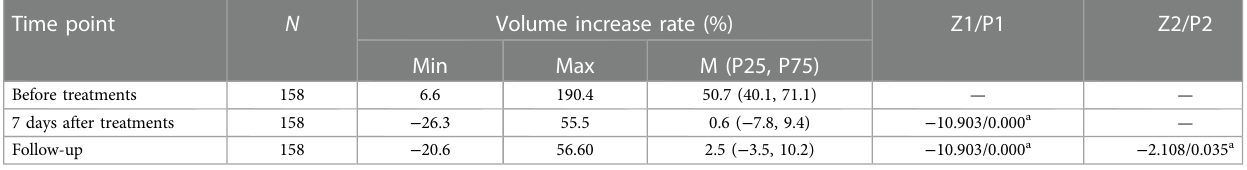
TABLE 4 Volume increase rate of bilateral arm before and after liposuction followed by lymphovenous anastomosis. Time